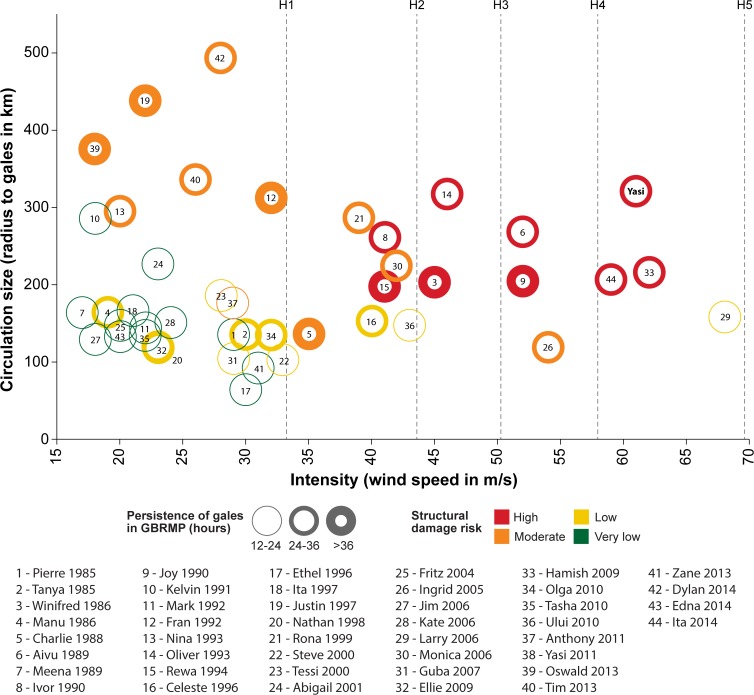
Potential for structural damage (very low to high) of GBR coral communities from tropical cyclones (TCs, 1985–2014).The 44 TCs are plotted on the diagram with respect to their intensity along the horizontal axis and their circulation size along the vertical axis. Of the 7 TCs that were large, only TC Yasi was also intense and posed a high risk of structural damage.